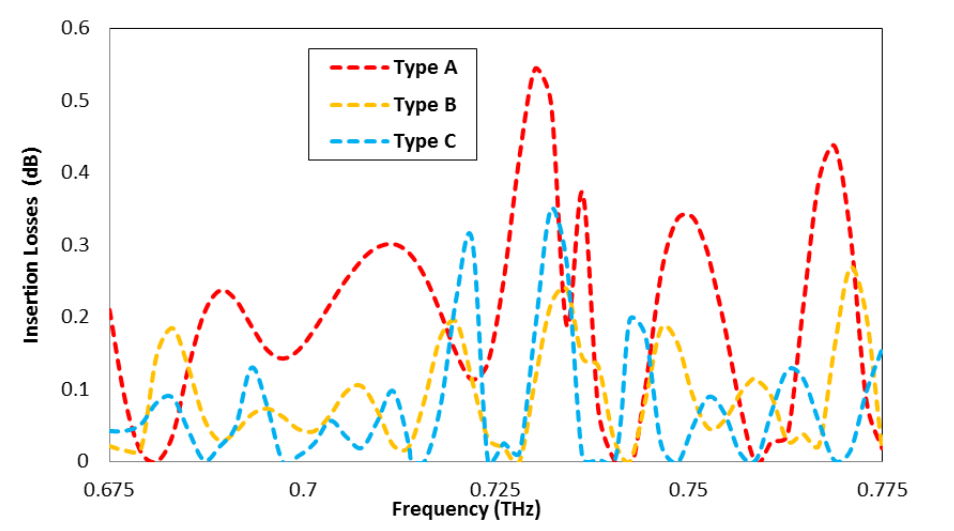
Figure 11. The insertion losses of Type A, Type B, and Type C antennas.